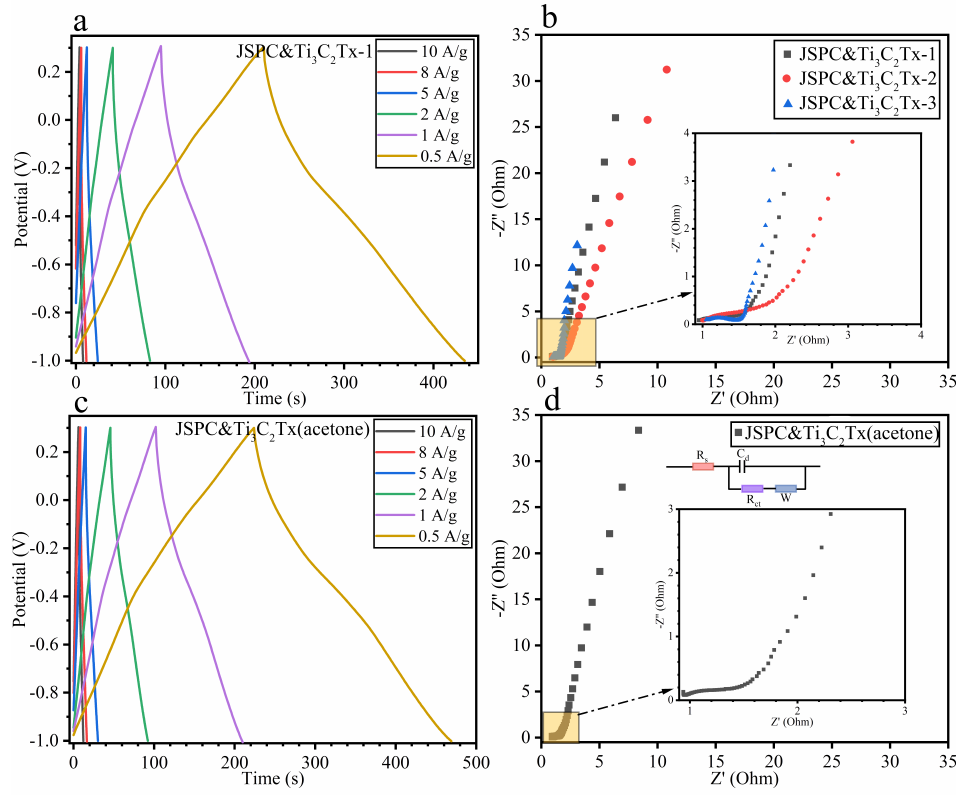
Figure 5. GCD and EIS curves of the composites. ( a , c ) refer the GCD curves of JSPC&Ti 3 C 2 Tx-1 and JSPC&Ti 3 C 2 Tx(acetone). ( b , d ) refer to EIS and equivalent current